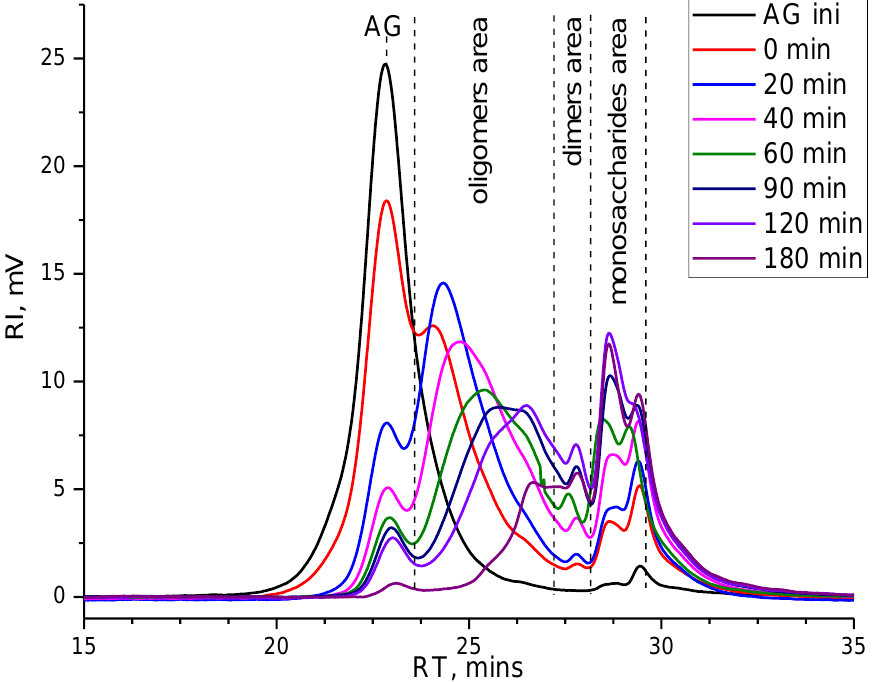
Figure 7. Gel permeation chromatogram of the arabinogalactan catalytic depolymerization products at temperature 130 °C.